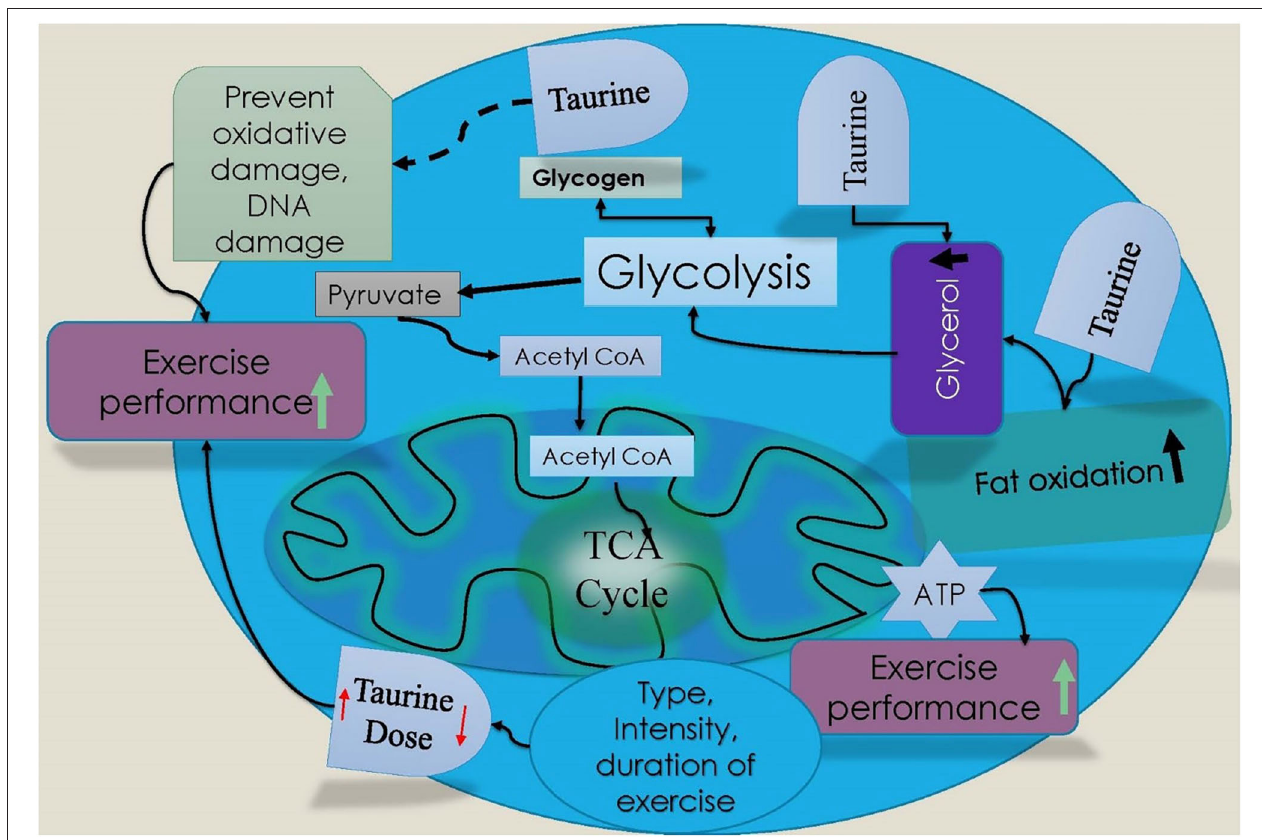
FIGURE 3 | Schematic diagram of taurine effect on exercise performance. Taurine is involved increase in fatty acid oxidation and glycerol during exercise, which could increase performance during high intensity exercise. Taurine‘s (Red arrow marks indicate taurine dose increase or decrease for exercise performance) role in increasing exercise performance depends on type, intensity, and duration of